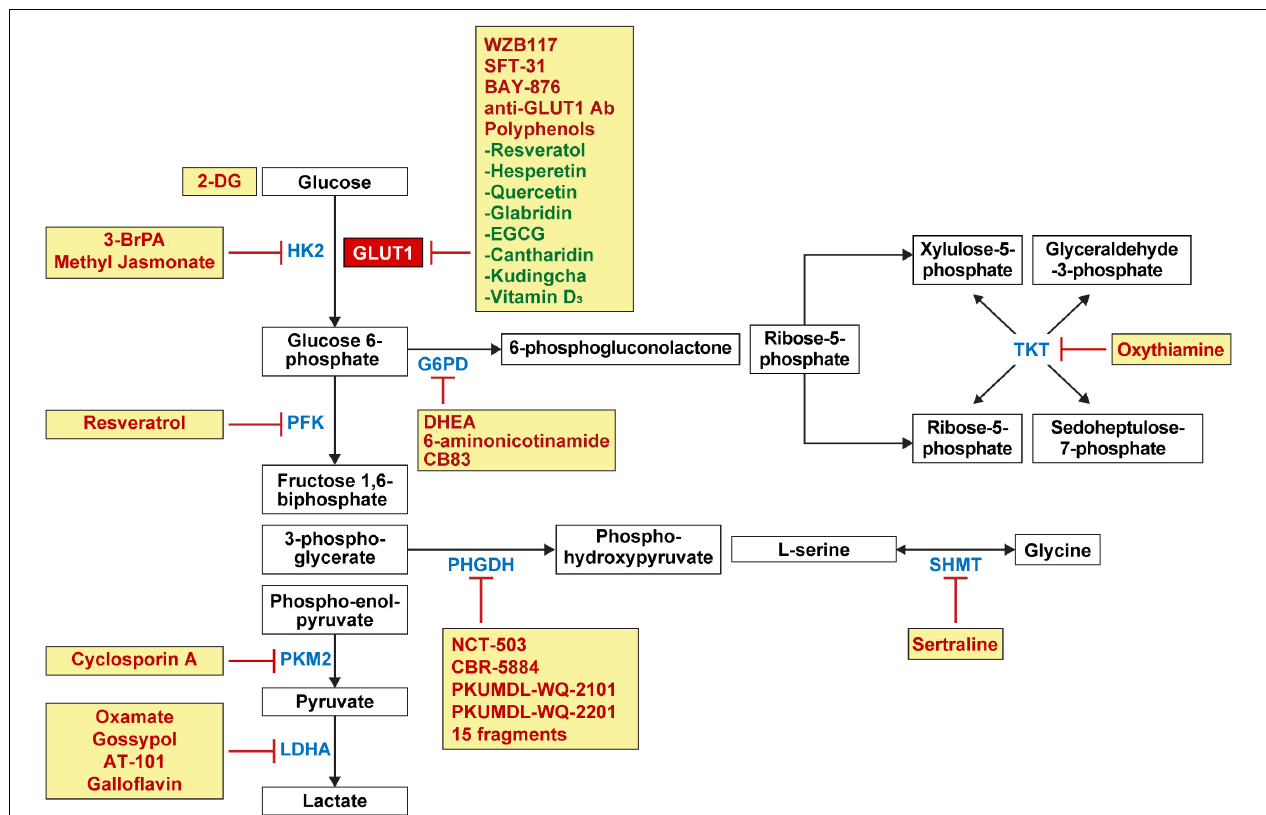
FIGURE 4 | Candidate drugs for the inhibition of glucose metabolism and glucose transporters in breast cancer. Inhibitors for GLUT1 involved in glucose influx in glycolysis include WZB117, SFT-31, BAY-876, anti-GLUT1 antibody, and polyphenols such as resveratrol, hesperetin, quercetin, glabridin, EGCG, cantharidin, kudingcha, and vitamin D 3 . 2-DG competes with glucose for binding GLUT1. Enzyme inhibitors for HK2 involved in glycolysis include 3-BrPA and methyl jasmonate, and resveratrol as PKF inhibitors; cyclosporine A as PKM2 inhibitor; and oxamate, gossypol, AT-101, and galloflavin as LDHA inhibitors. Enzyme inhibitors for